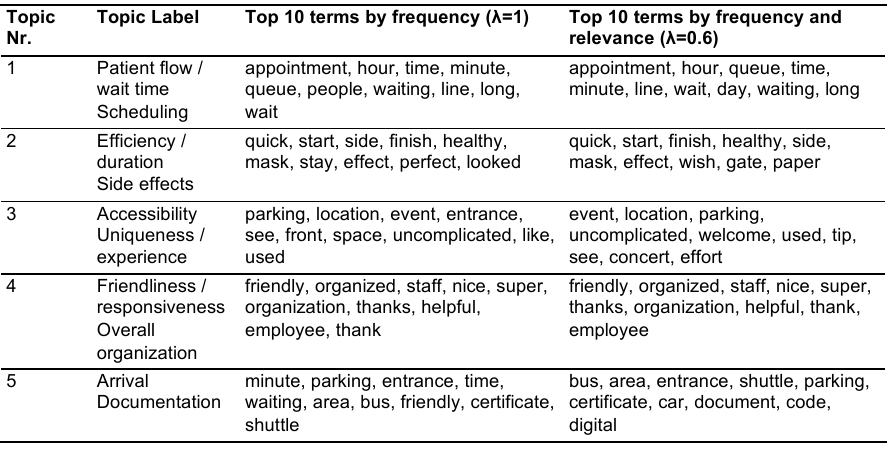
Figure 3. Results from topic modeling. ( A ) Intertopic distance map of five optimally latent topics and ( B ) top 10 terms per topic by frequency and relevance. In the intertropic distance map, each circle represents one topic. The circle size represents the relative number of terms that belong to the topic. The distance between circles represents the relative similarity and connectedness of topics. Topic circles that are closer to each other have more terms in common. For the top 10 terms per topic, the most frequent terms within a topic are shown at λ -value 1, and the top terms combining frequency and relevance are shown at λ -value 0.6. Relevance reflects the level at which a term exclusively belongs to a single topic. The λ -values 1 and 0.6 are suggested by the prior literature to analyze topics (see Section 2.2.1).